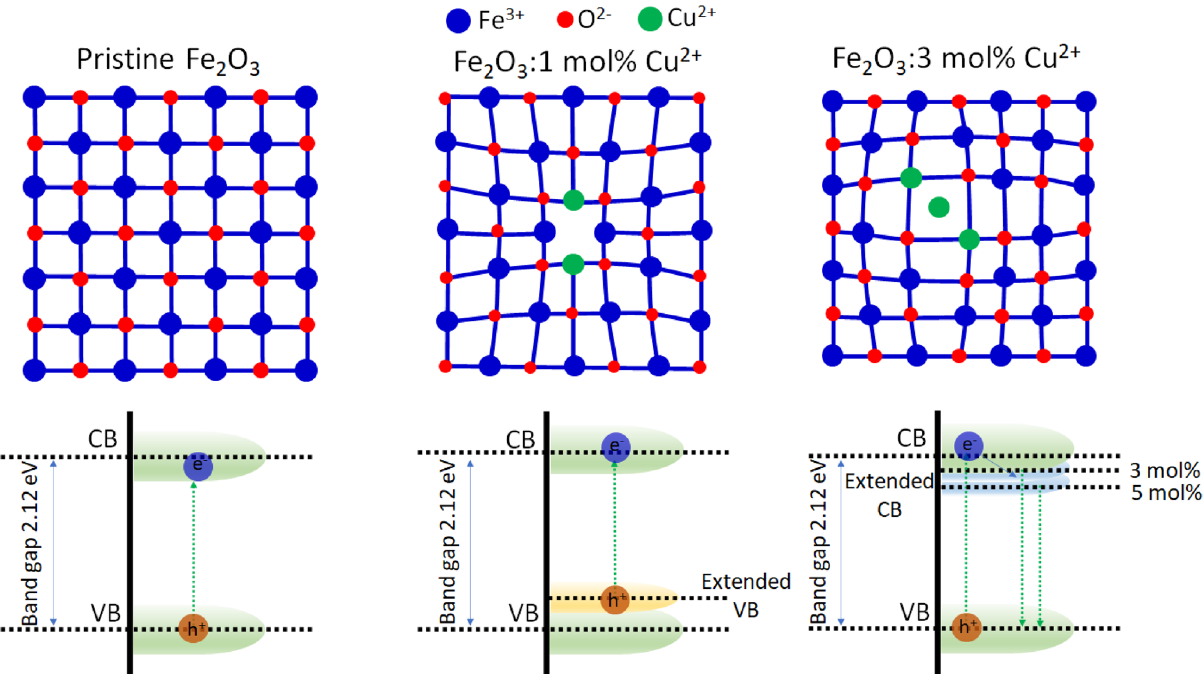
Figure 3. Schematic representation of defect formation and band gap modification with different amount of Cu 2+ doping into hematite. Pristine hematite ( a -Fe 2 O 3 ) does not show any bond deformation and compression but in 1 and 3 mol% Cu 2+ doped a -Fe 2 O 3 show bond or lattice compression and deformation due to defect formation. The effect of defects on band energy diagram are presented with extended VB and CB energy level.